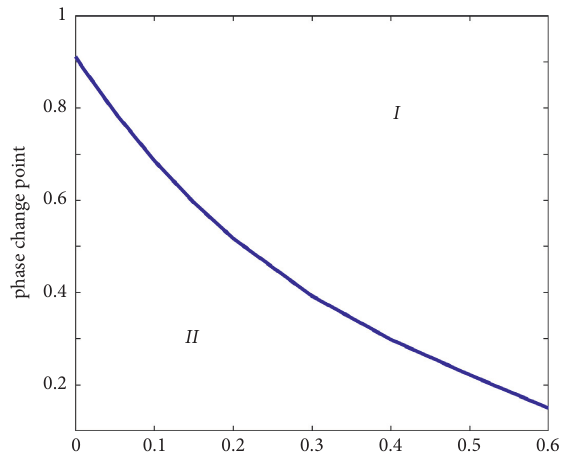
Figure 6: The phase change point of the corresponding measures intensity under different diagnosis rates.